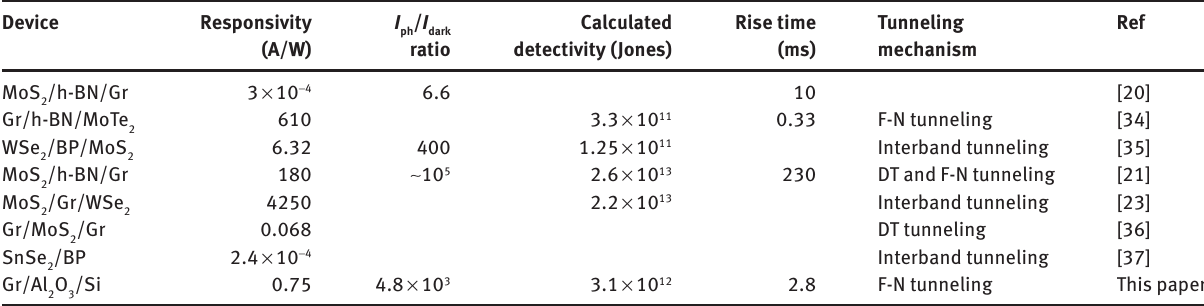
Table 1: Comparison of 2D materials-based tunneling photodetectors with different tunneling mechanisms.